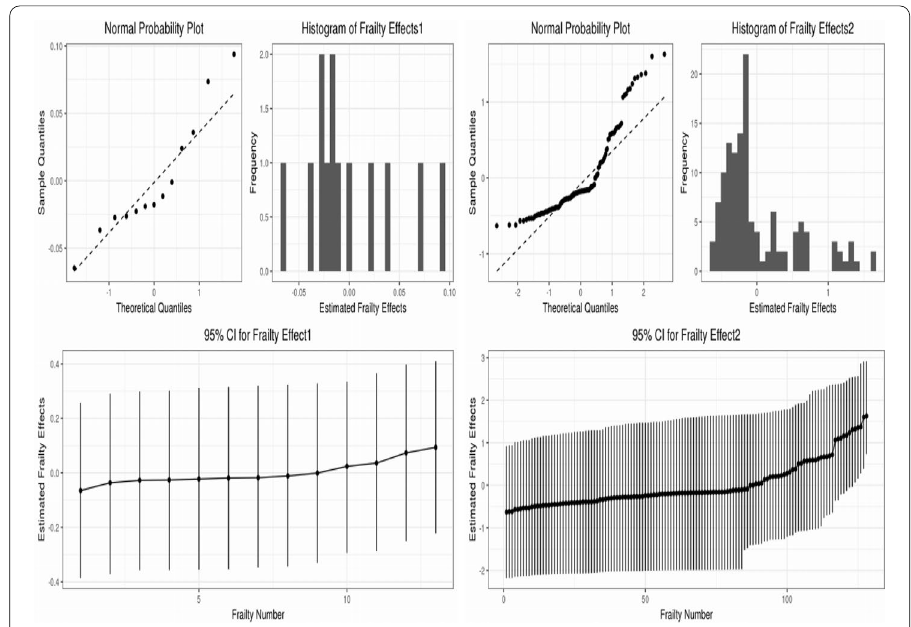
Fig. 10 Estimated frailty effects in the CGD recurrent infection